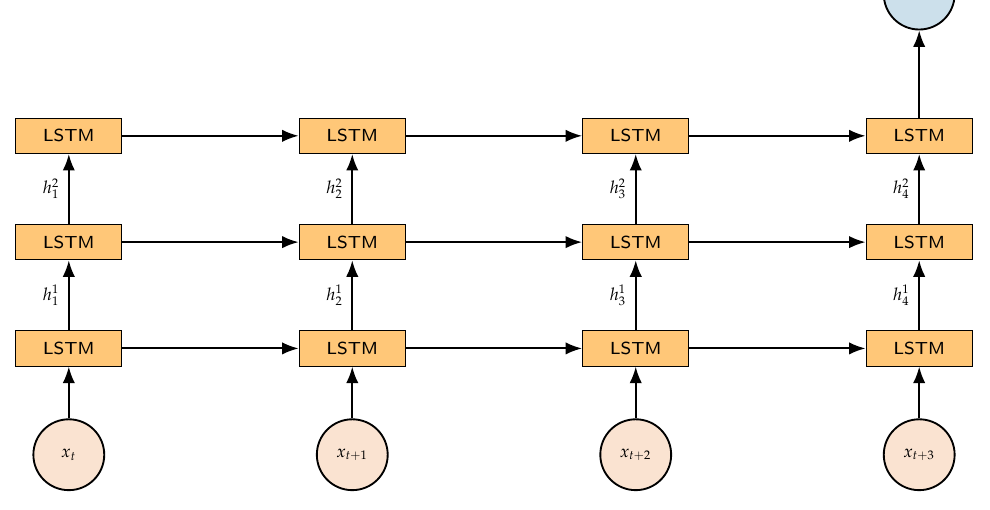
Figure 5. Stacked LSTM architecture.